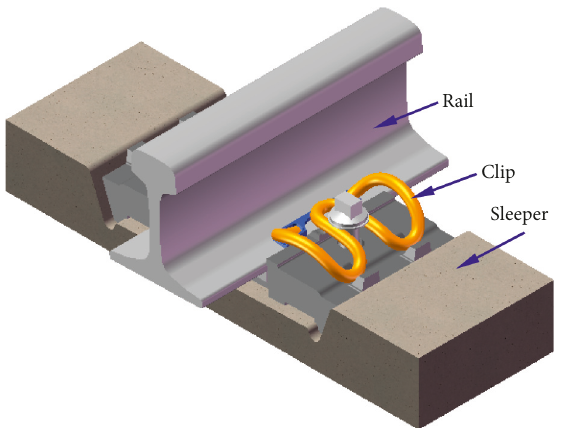
Figure 1: A model of the ω -type fastening.